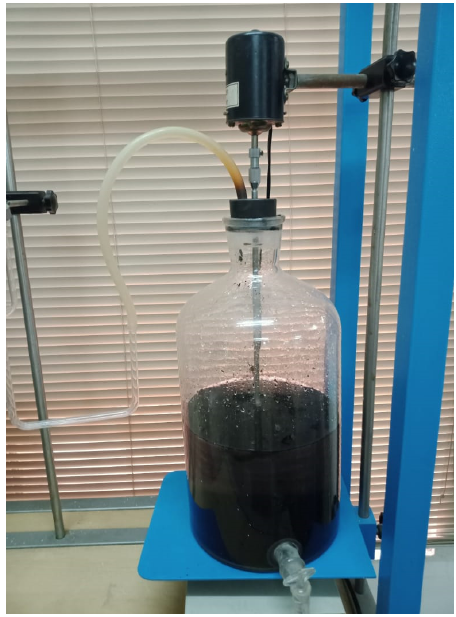
Figure 2. Lab-scale anaerobic reactor for industrial beverage wastewater with 3 mg/L activated carbon for pre-treatment.